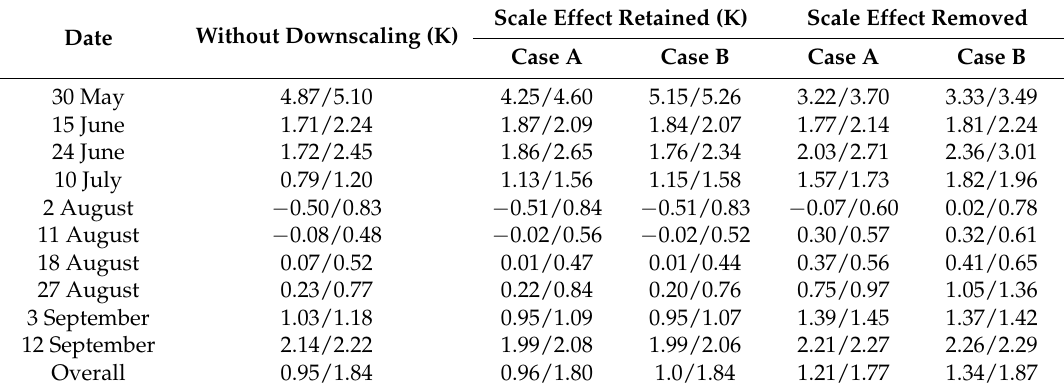
Figure 7. ( a – l ) The ASTER LSTs downscaled from 90 to 15 m with GRM in Case B during the complete crop growing season in the Zhangye oasis and its surrounding areas. LSTs of the areas outside the oasis were downscaled by uniform disaggregation. Table 2. MBE and RMSE values of the LSTs downscaled with GRM validated based on in situ LSTs at all sites except EC04.